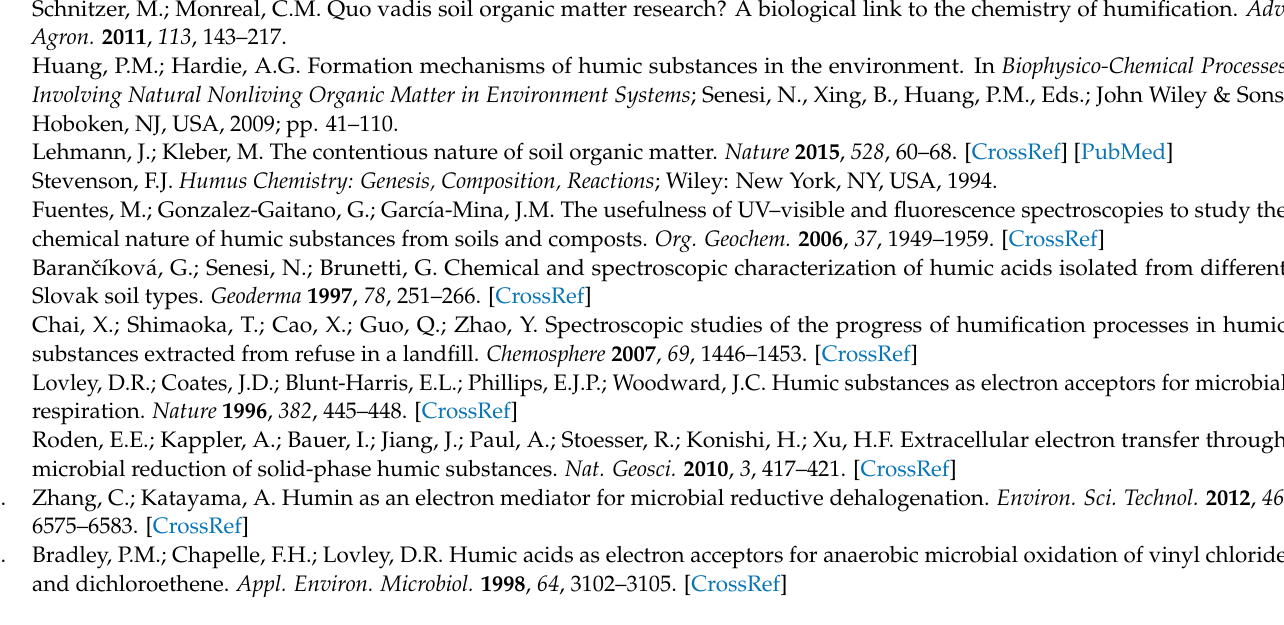
Figure S12: ESR spectra of Mix-3M; Figure S13: ESR spectra of Mix2 samples in the second time experiment; Figure S14: cyclic voltammograms of rice straw and Mix-0M-C; Figure S15: EIS Bode plots of Mix samples; Figure S16: changes in EEM functionality of Mix samples in the culture without formate; Figure S17: no EEM functionality of selected microbial biomass; Figure S18: sulfur